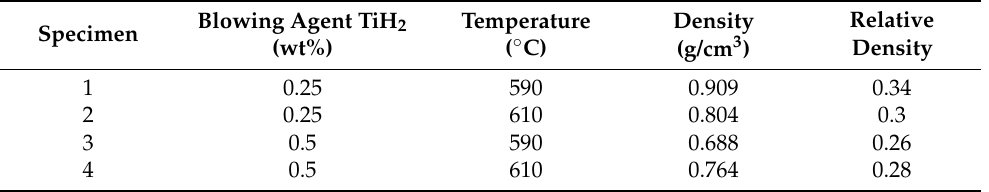
Table 1. Preliminary foaming parameters for metal foam growth